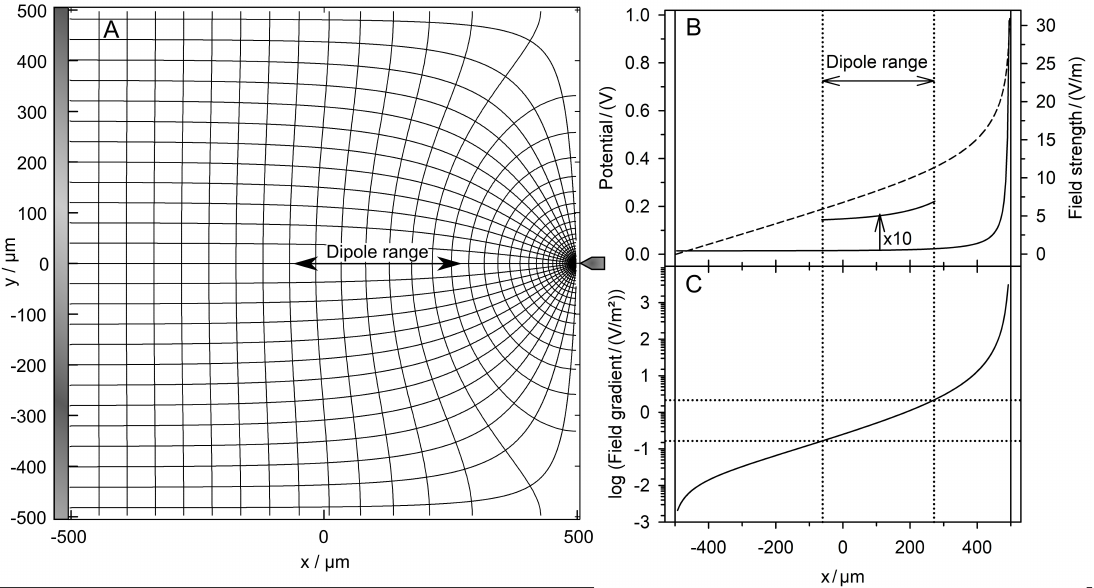
Figure 2. ( A ) Potential and current line distributions in the 1 × 1-mm 2 chamber without the sphere energized with 1 V at the pointed electrode (center right) versus 0 V at the plain electrode (vertical gray bar on the left). At the symmetry line, the dipole range is marked. ( B ) Potential (dashed) and field strength (full) along the symmetry line of the chamber (500 µ m ≤ x ≤ 500 µ m, y = 0 µ m). Vertical lines mark the limits of the chamber volume. The curve was enlarged by multiplication with a factor of 10 to show the field behavior in the dipole region more clearly. ( C ): Field gradient along the symmetry line.